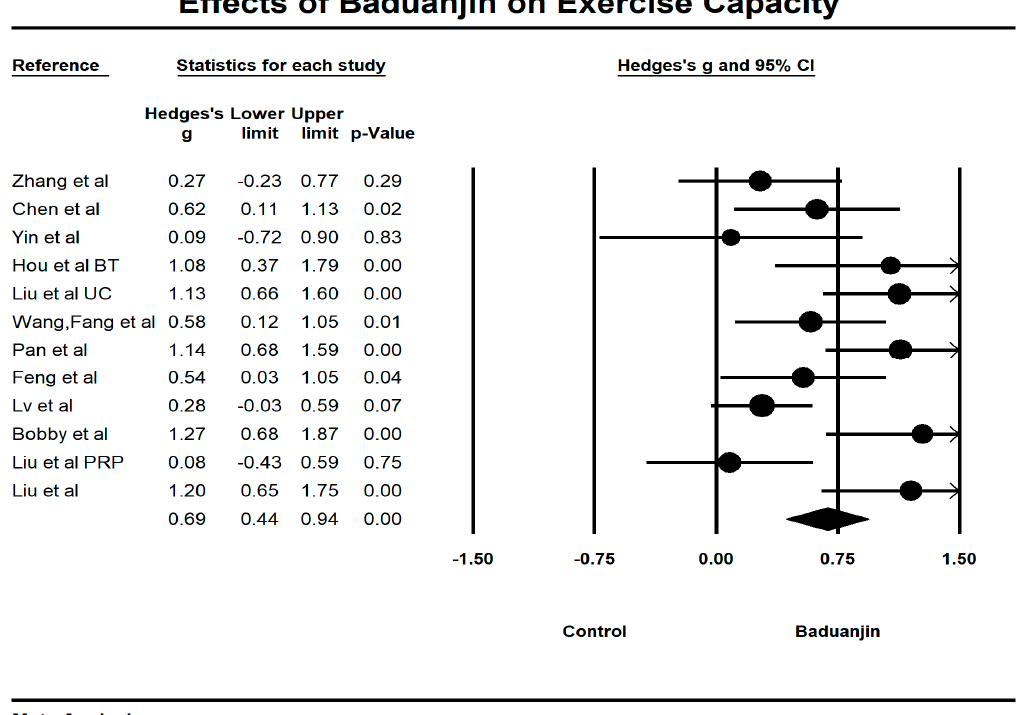
Figure 3. Effects of Baduanjin on exercise capability measured by the 6-MWT (BT = breathing technique; PRP = conventional pulmonary rehabilitation; UC = usual care).